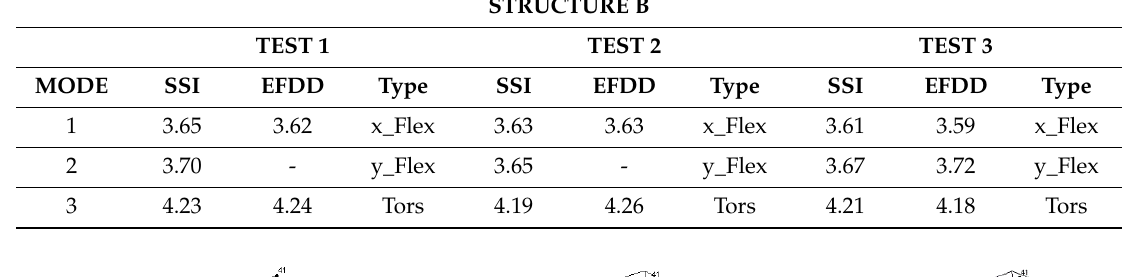
Table 2. Experimental identified frequencies [Hz] with SSI and EFDD techniques and mode shape type.